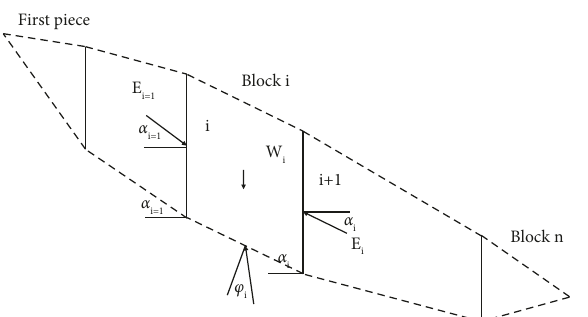
Figure 4: Block diagram of sliding body using the transfer coef- ficient method.